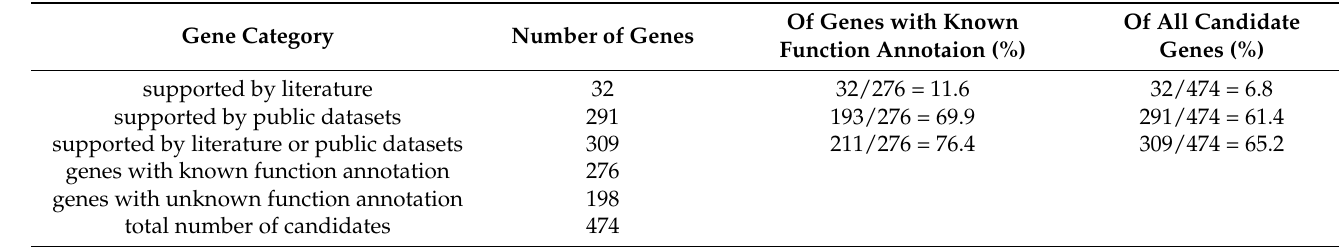
Table 1. Results of prediction evaluation of auxin-responsive genes based on computational